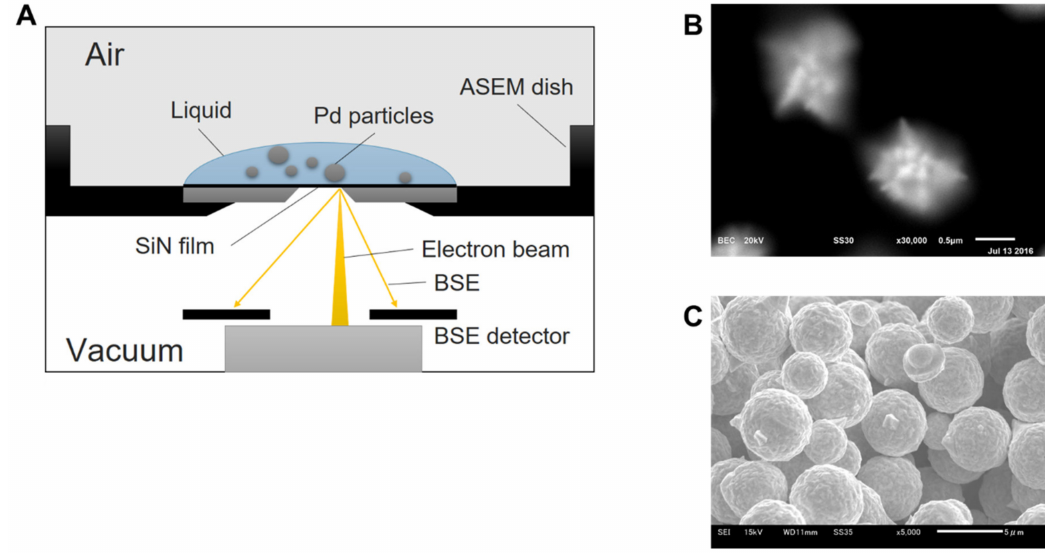
Figure 1. Images of Au micrometer-size particles taken by atmospheric scanning electron microscopy (ASEM) and a traditional SEM. ( A ) Schematic diagram of ASEM system. The ASEM system is composed of an inverted SEM system and a silicon nitride (SiN) thin-film electron transparent windowed sample holder, and enables researchers to observe samples immersed in liquid under atmospheric pressure. Resolution of ASEM is 8 nm near SiN membrane [15]. ( B ) ASEM images of gold particles synthesized in the liquid after 37 min at a magnification of × 30,000 [11]. ( C ) Image of gold particles after filtered and dried, taken by a traditional SEM